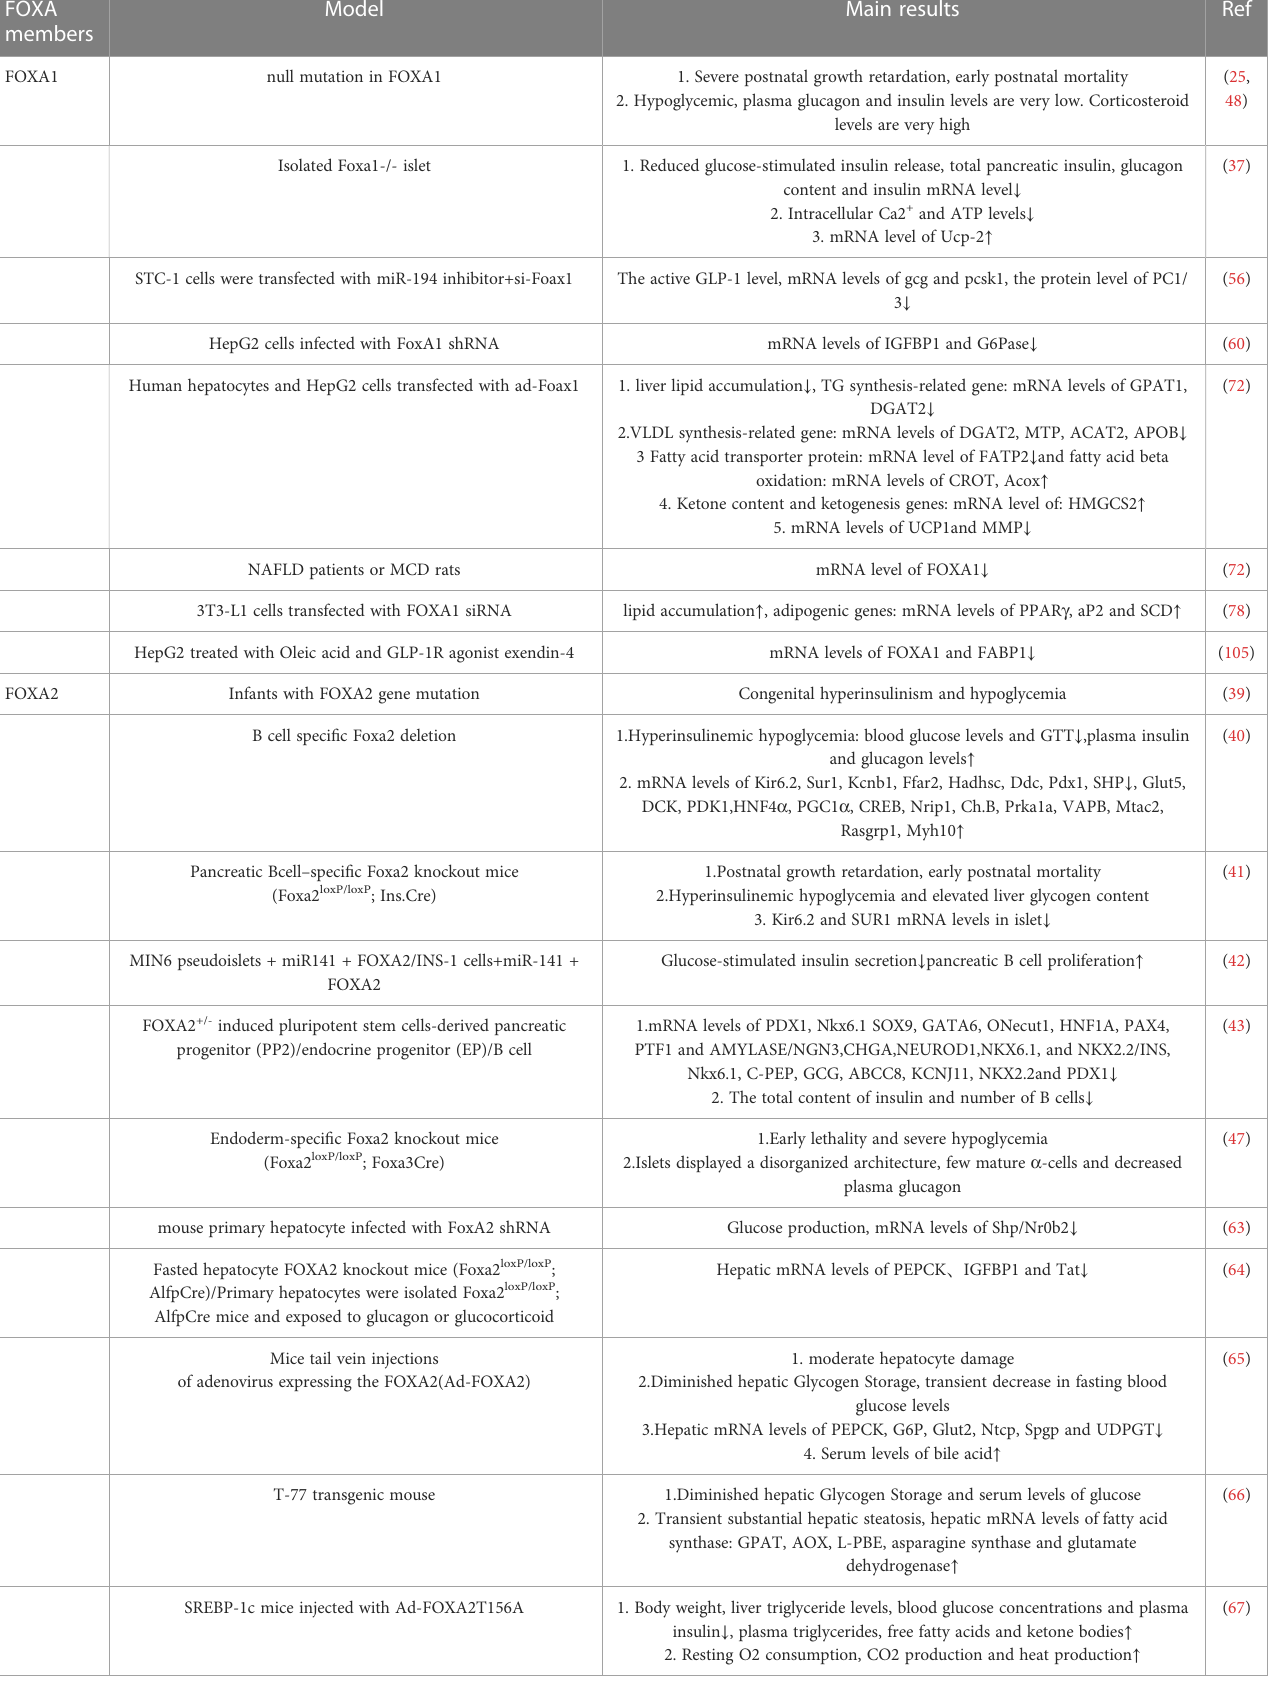
TABLE 2 Contribution of forkhead box (FOX) protein to glycolipid